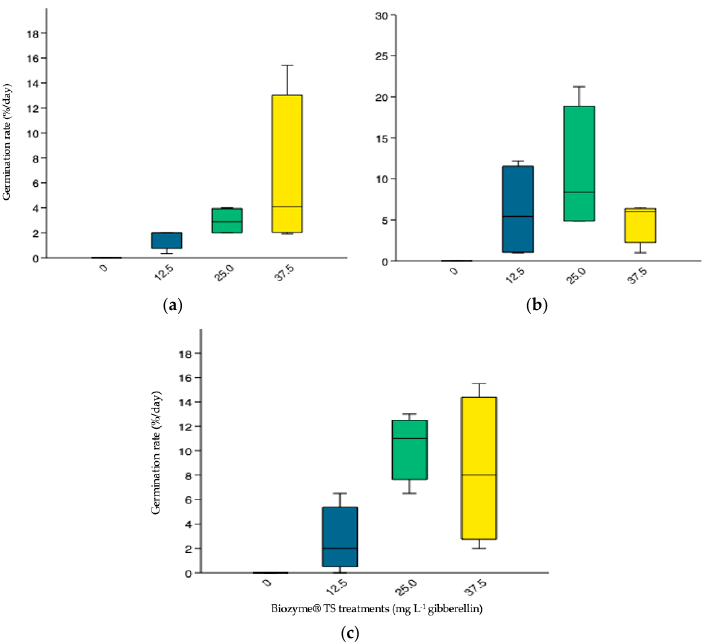
Figure 7. Response of germination rate (GR) to Biozyme ® TS (gibberellins), with: ( a ) 24 h, ( b ) 48 h, and ( c ) 72 h of